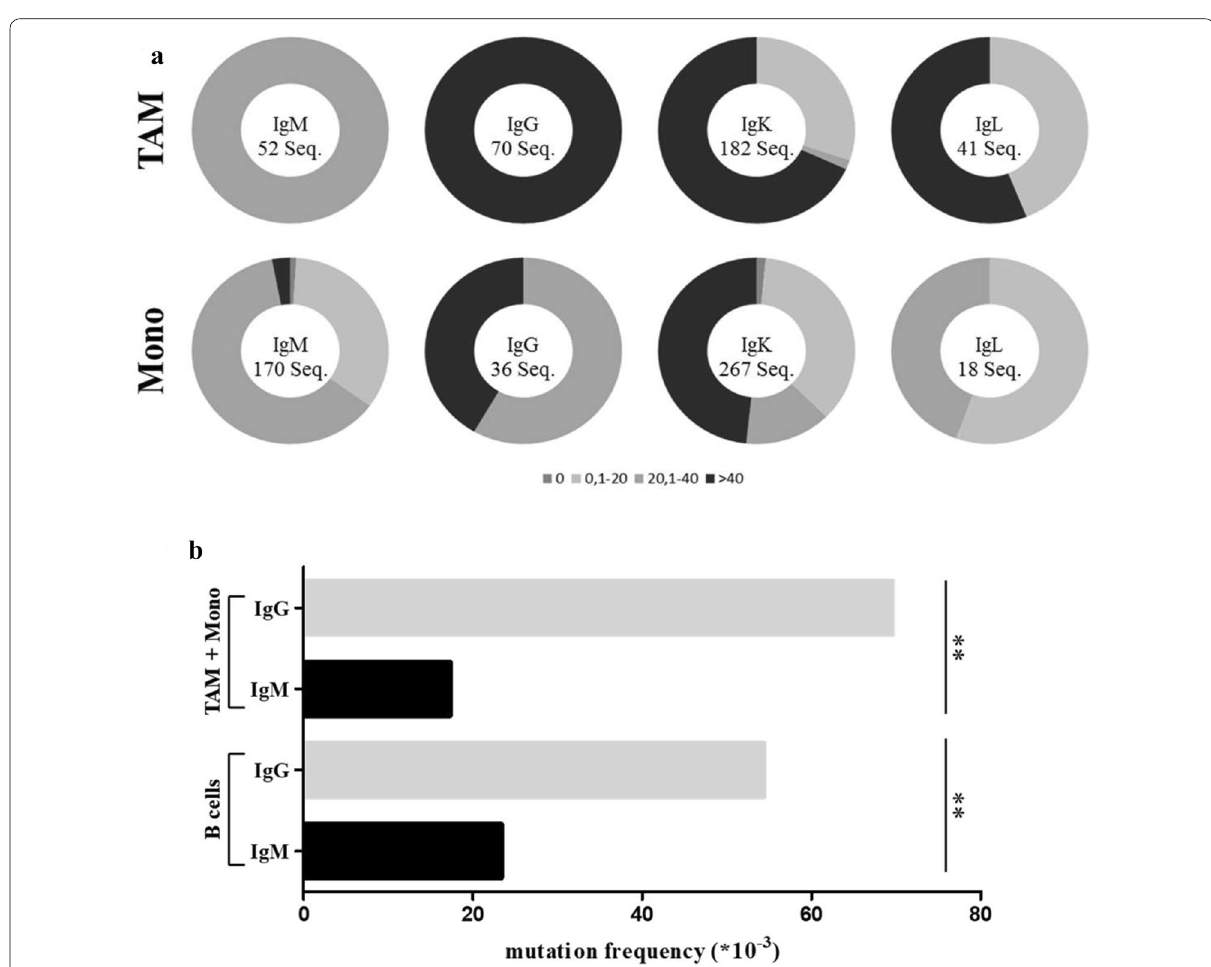
Fig. 5 Mutation frequencies in tumor‑associated macrophages and circulating monocytes. a The mutation frequencies ( chains IgM and IgG as well as the light chains Igκ and Igλ of tumor‑associated macrophages and circulating monocytes are demonstrated. For all four Ig classes higher mutation rates were found in TAM than in circulating monocytes. The mutation frequencies were clustered in different categories depending on the number of mutations per V H region gene (0; 0.1–20; 20.1–40; > 40). b The overall mutation frequencies of IgM and IgG heavy chains in monocytes/macrophages and B cells are shown. The investigated tumor‑associated macrophages and circulating monocytes show the same distribution of mutations as their corresponding B cells. In all investigated cell types, the mutation frequency for IgG is significantly higher (p > 0.01) than for